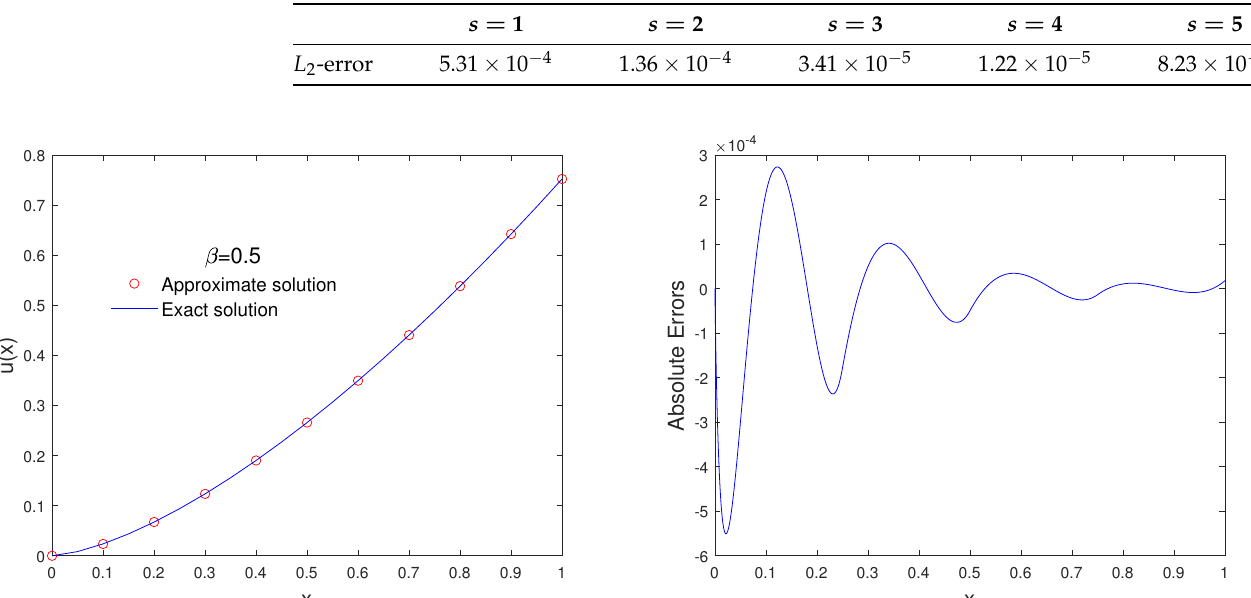
Table 2. The effect of parameter s on L 2 -errors for Example 1.